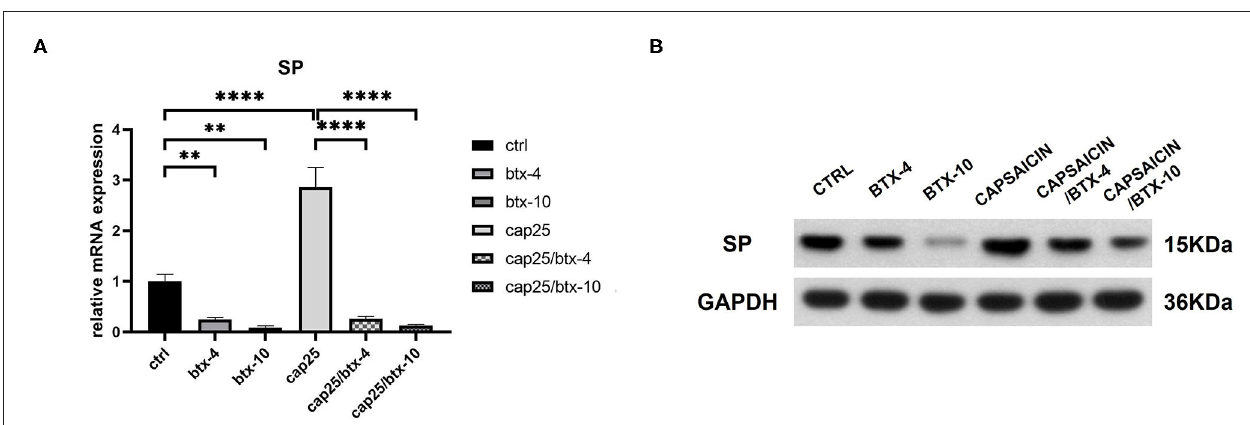
FIGURE 4 | The mRNA and protein expressions were from hypertrophic scar-derived fibroblasts treated with BTX-A (4 or 10 U/mL) and capsaicin (25 µ M/L). (A) Relative mRNA expression of SP after treatment with BTX-A and capsaicin separately or in combination; (B) Expression of SP after same BTX-A and capsaicin treatment detected by western blot analysis. The results are represented as the mean of 3 experiments ± SD, which were performed in duplicate for each experimental condition (** P < 0.01; **** P < 0.0001). ( Figures 9A,B ). The thickness of the scar tissues was